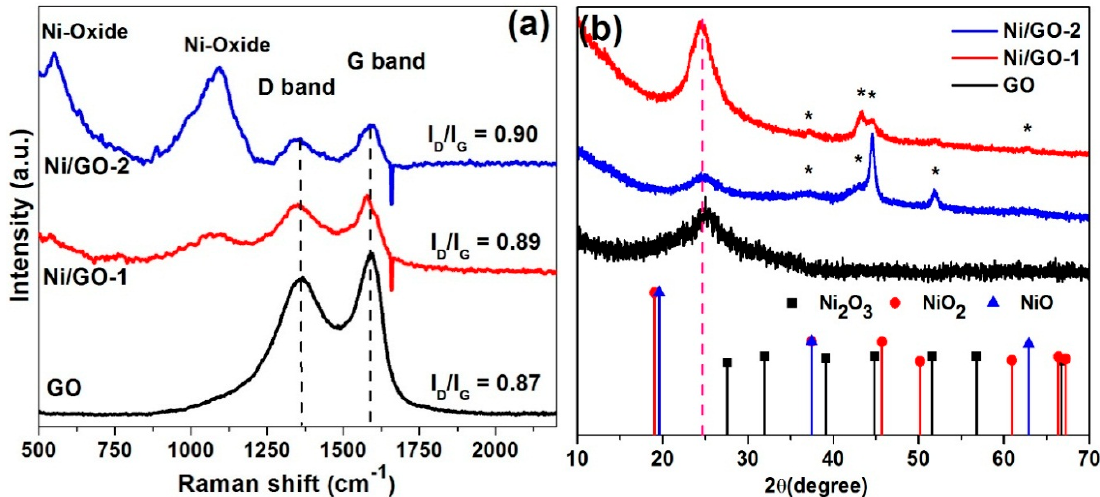
Figure 5. ( a ) Raman spectra and ( b ) XRD pattern of GO, Ni / GO-1 and Ni / GO-2.